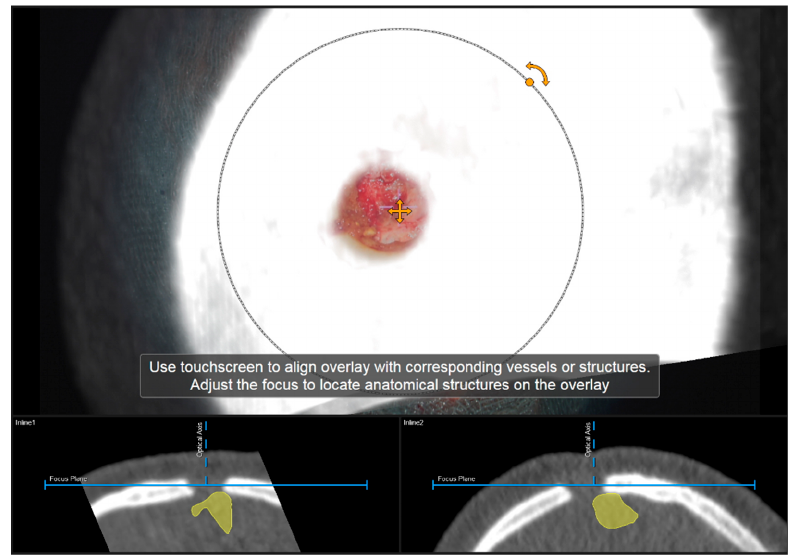
Figure 4. Evaluation of navigation accuracy using a CT-based MIP projection centered at a burr-hole of a prior biopsy surgery, showing a good match of image and patient data (In parallel view of MIP projection (upper part) and inline views with the recent focus plane (blue line) and the optical axis (dashed blue line) in the bottom part).